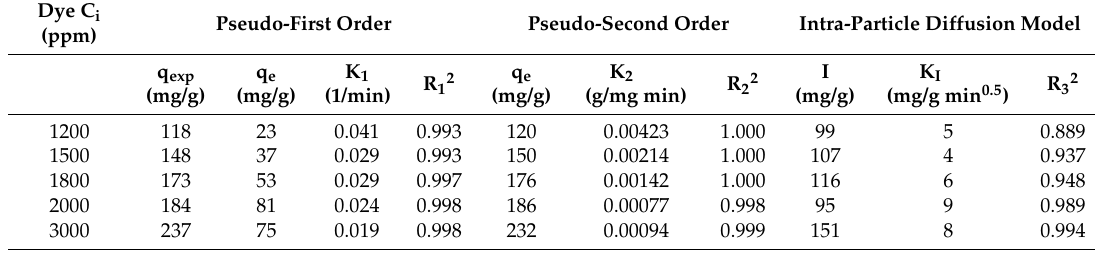
Table 2. Kinetic parameters for removal of MB using MNS-4.